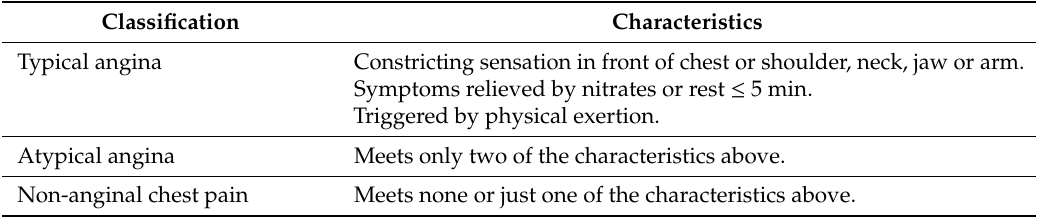
Table 1. Characteristics of coronary artery disease (CAD) symptoms, modified from